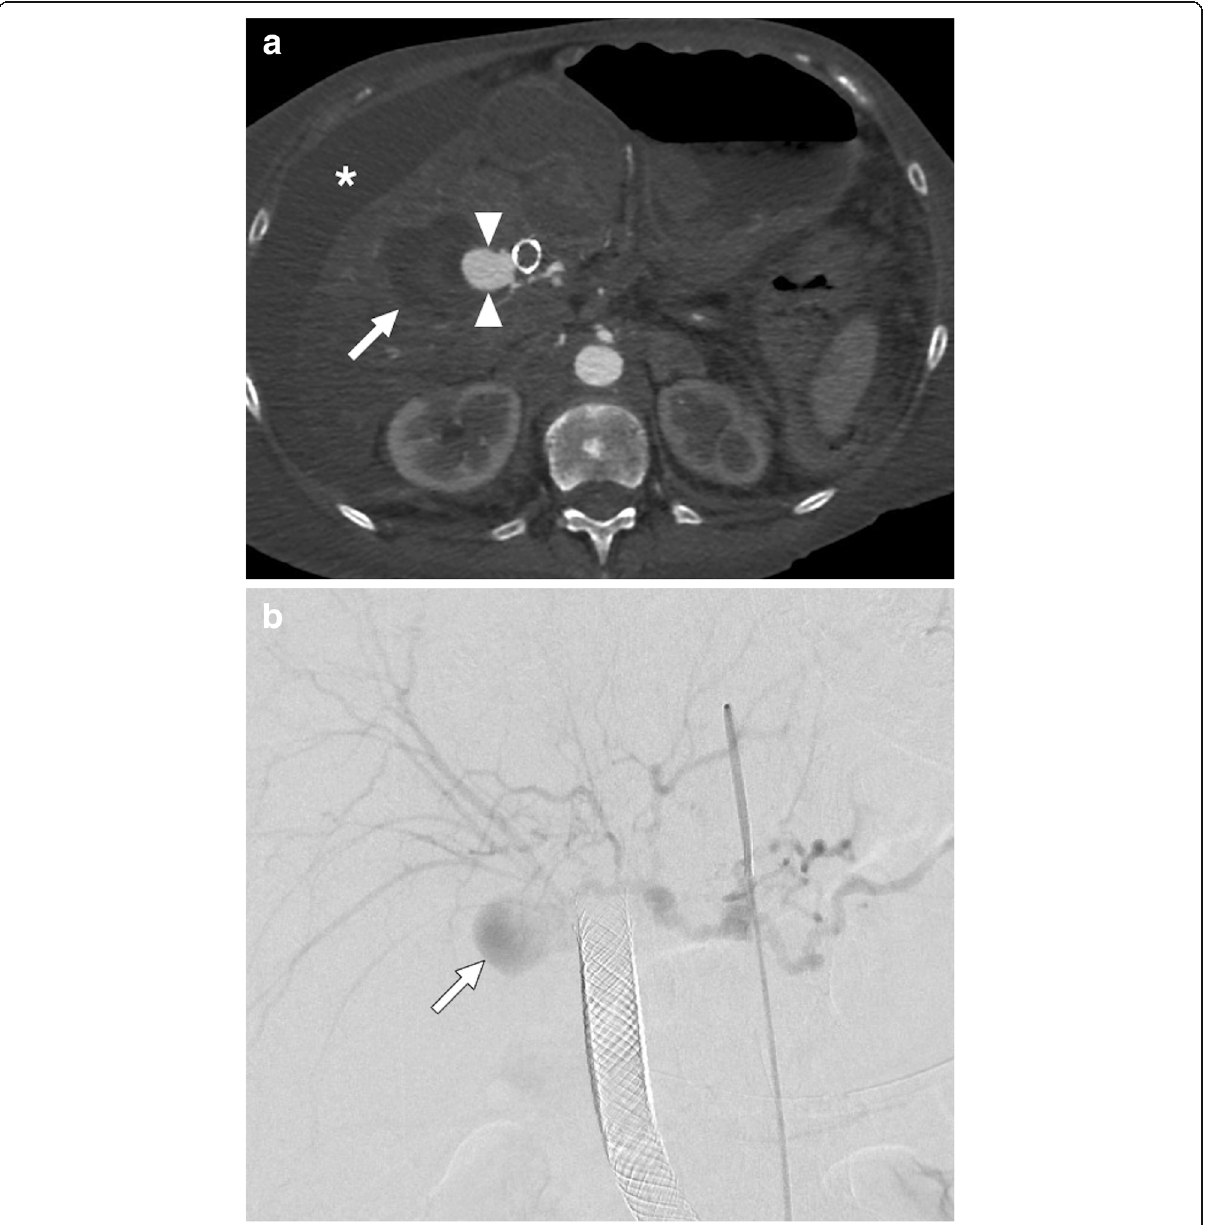
Fig. 9 Hepatic artery pseudoaneurysm. A 69-year-old female with known inoperable obstructive hilar cholangiocarcinoma cancer treated with palliative biliary stenting. About 3 h after the procedure, the patient experienced severe right upper quadrant pain, hematemesis and hypotension. a Axial post-contrast arterial phase CT image demonstrates a large pseudoaneurysm (arrowheads) right next to the metallic biliary stent. Also, note is made of newly developed intraparenchymal hematoma (arrow) and intraperitoneal high-density free fluid suggestive of hemoperitoneum (asterisk). b Emergent catheter angiography confirmed the presence of pseudoaneurysm (arrow) originating from the right hepatic artery. The pseudoaneurysm was subsequently embolized with coils and the patient recovered rapidly after the